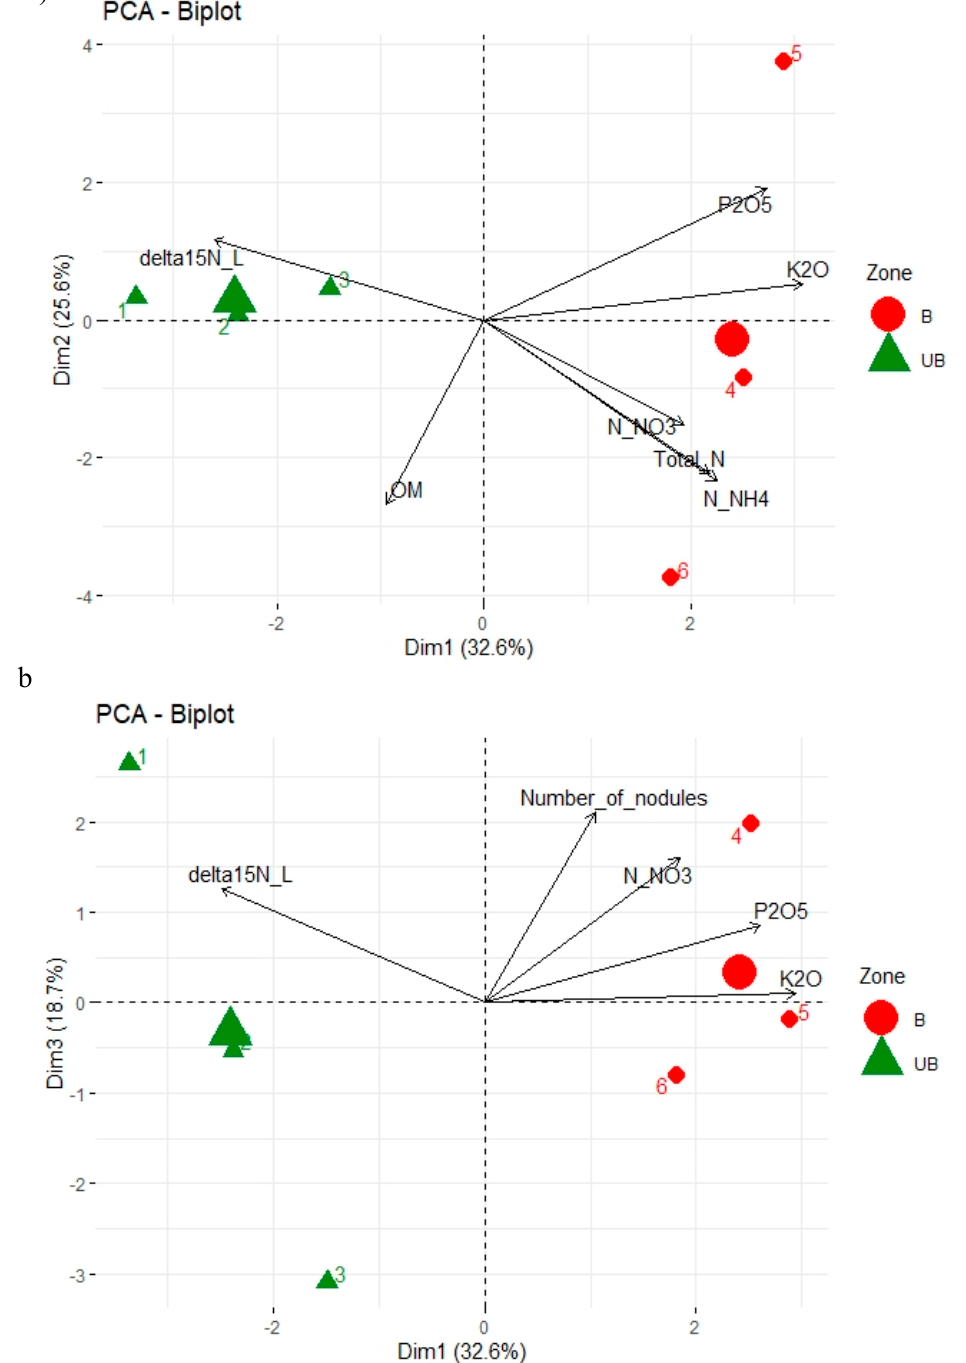
Figure 2. Principal Component Analysis (PCA) of soil properties and isotopic analysis from all unburnt (UBZ) and burnt zones (BZ), represented by Dim1 and Dim2 in ( a ) and Dim1 and Dim3 in ( b ). Only the main contributory variables to Dim1 and Dim2 are represented in ( a ), which are δ 15 N_L ( δ 15 N in leaves), P2O5 (phosphorus), K 2 O (potassium oxide), N_NO 3 (nitrates) for Dim1 and OM (organic matter), Total_N (total nitrogen) and N_NH 4 (ammonia) for Dim2; only the main contributory variables to Dim1 and Dim3 are represented in ( b ), which are the number of nodules for Dim3. Numbers 1, 2 and 3 represent the UBZ 1, UBZ 2 and UBZ 3 zones respectively, while 4, 5 and 6 represent the BZ 1, BZ 2 and BZ 3 zones.